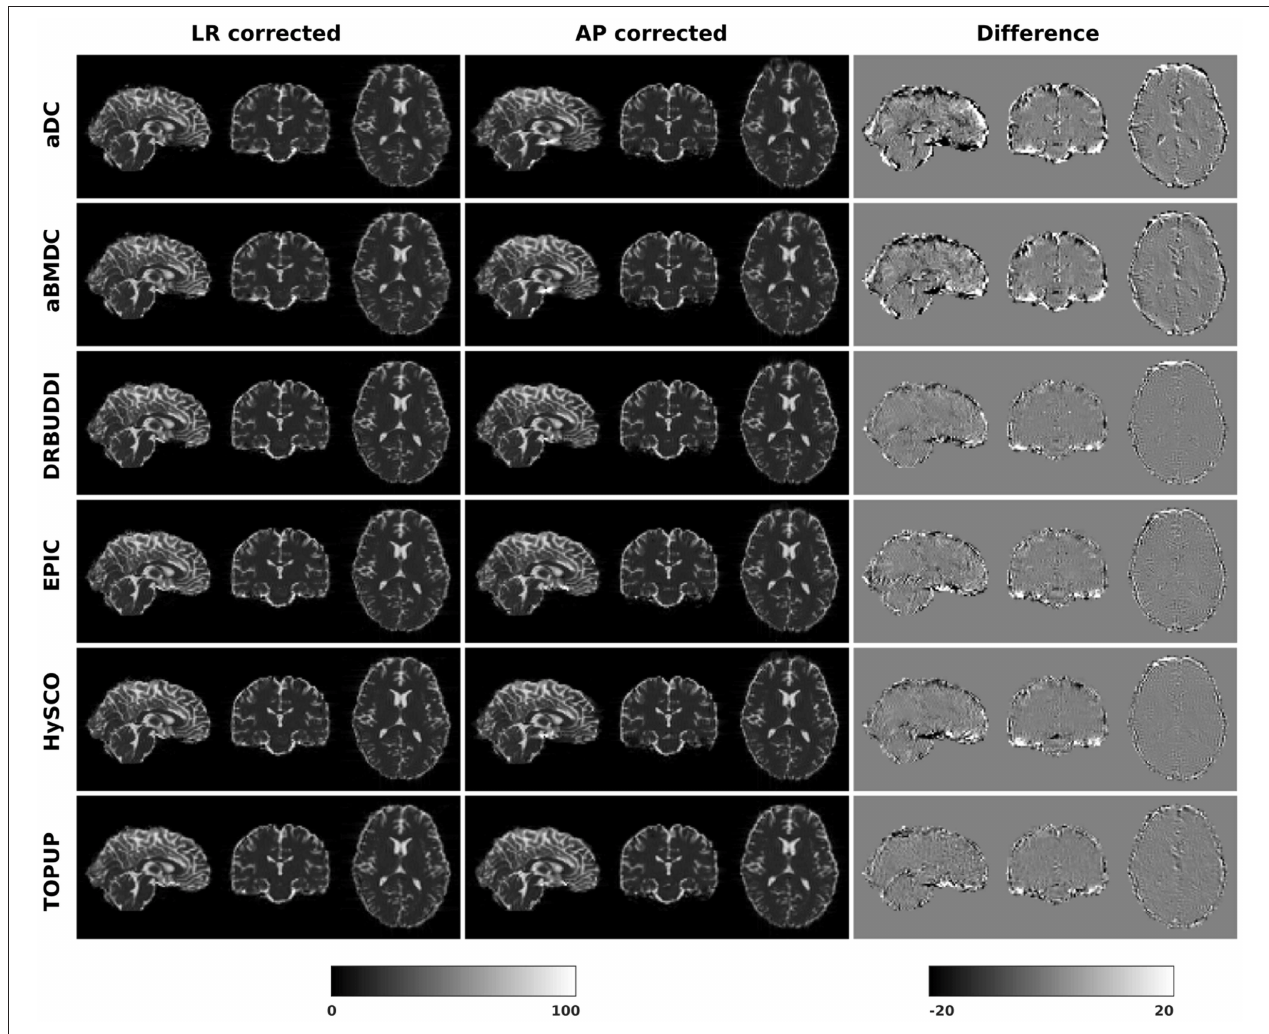
FIGURE 10 | Difference between corrected b 0 volumes from LR and AP for simulated HCP Subject 100206 using the six methods.